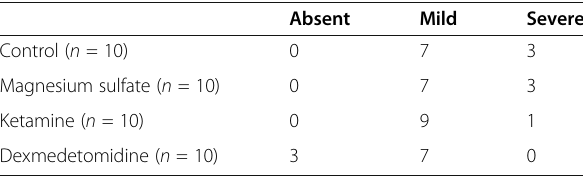
Table 2 Comparison of study groups in terms of Myelin degeneration